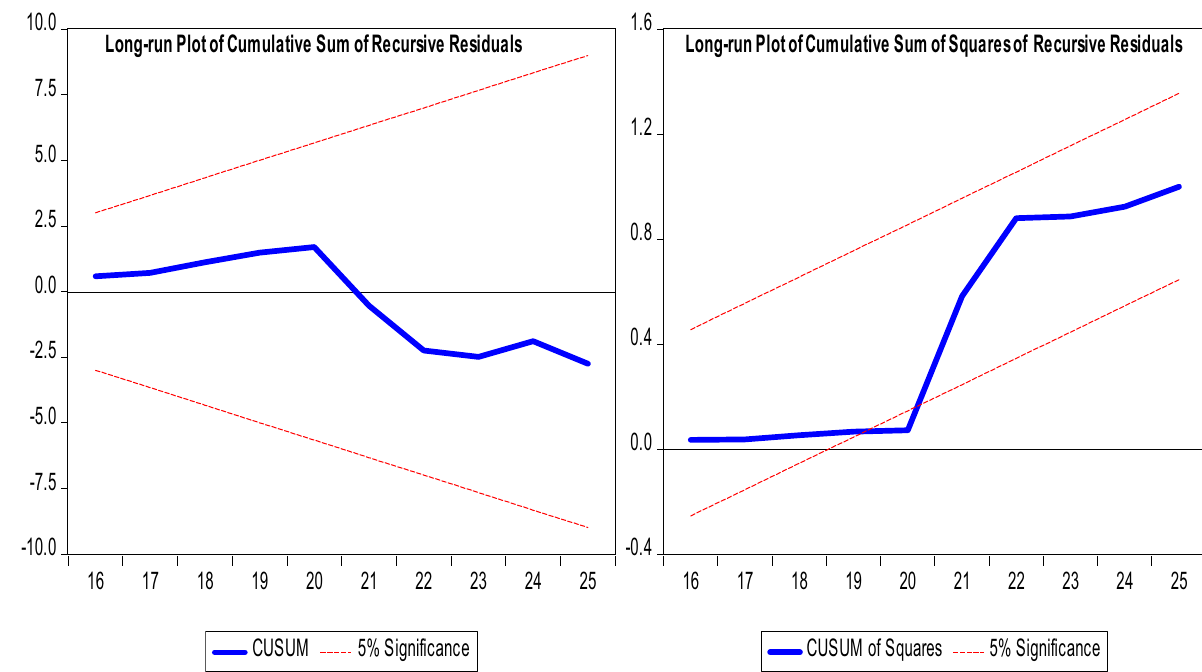
Fig. 1 Plot of Cummulative sum of Recursive Residuals (CUSM) for ARDL